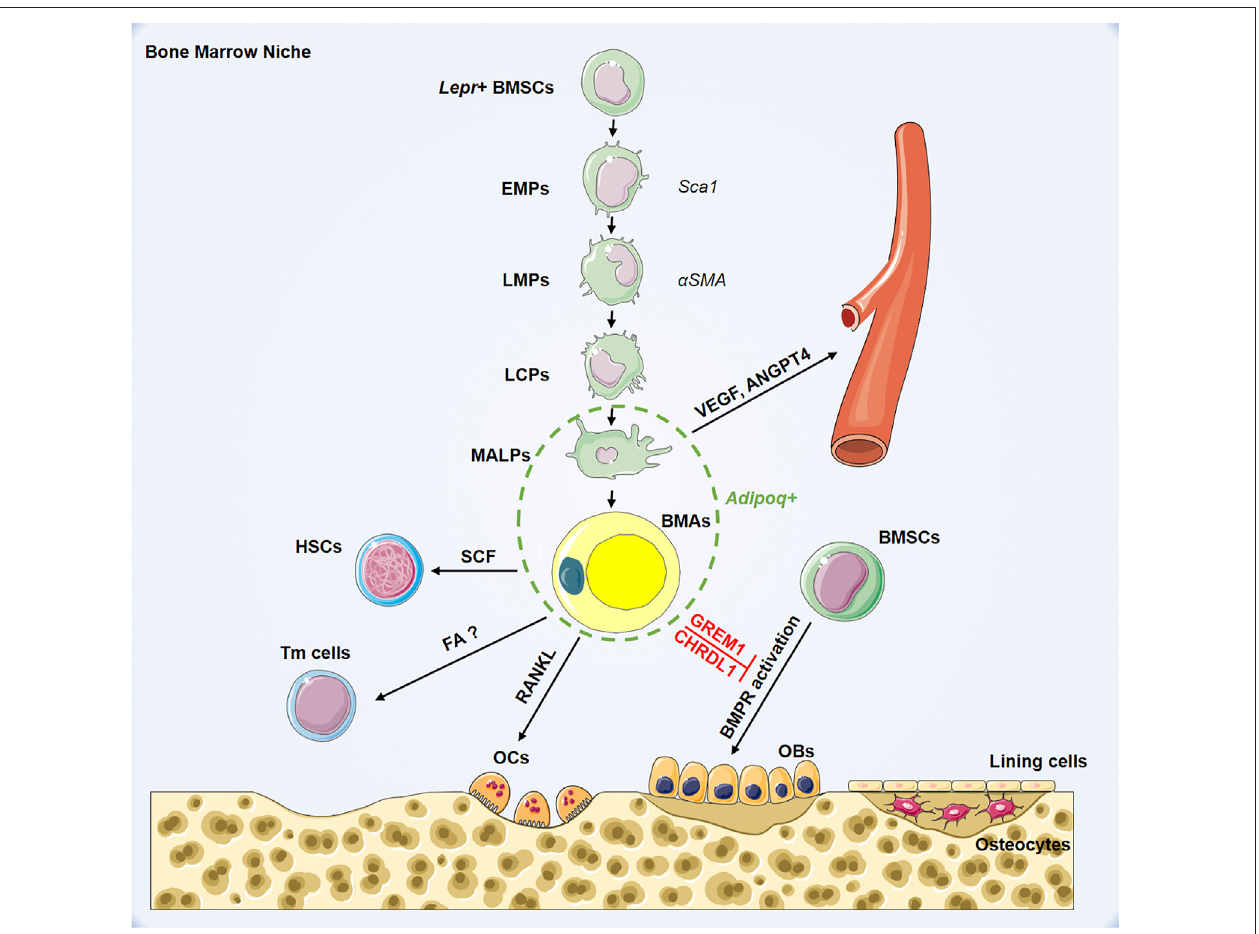
FIGURE 1 | Hierarchy of bone marrow adipocyte lineage cell and its role in bone marrow niche. BMSCs: bone marrow mesenchymal stromal cells; EMPs: early mesenchymal progenitors; LMPs: late mesenchymal progenitors; LCPs: lineage committed progenitors; MALPs: marrow adipogenic lineage precursors; BMAs: bone marrow adipocytes; HSCs: hematopoietic stem cells; Tmcells: T memory cells; OCs: osteoclasts; OBs: osteoblasts; Lepr : leptin receptor; Sca1 : stem cell antigen 1; α SMA : smooth muscle actin alpha; Adipoq : adiponectin; SCF: stem cell factor; RANKL: receptor activator for nuclear factor- κ B ligand; FAO; VEGF: vascular endothelial growth factor; ANGPT4: angiopoietin 4; GREM1: gremlin1; CHRDL1: chordin-like1; BMPR: bone morphogenetic protein